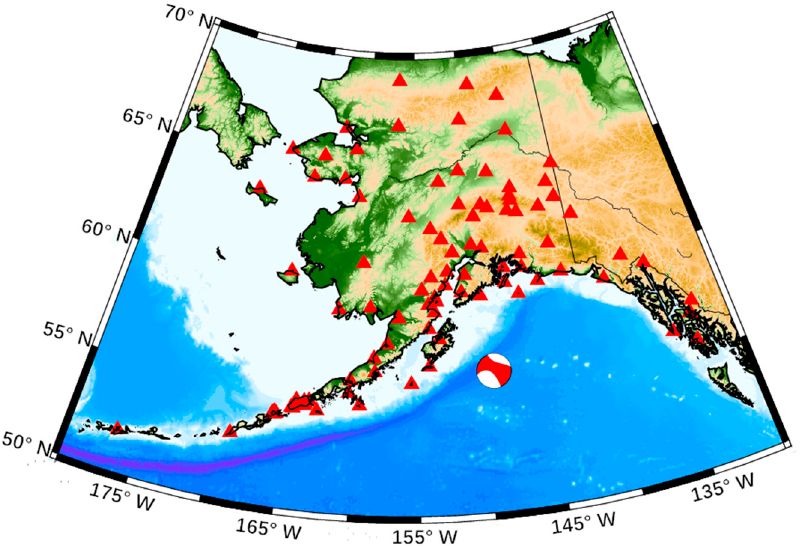
Figure 1. Distribution of continuously operating reference stations (CORS) in Alaska, and beach ball represents the epicenter. represents the